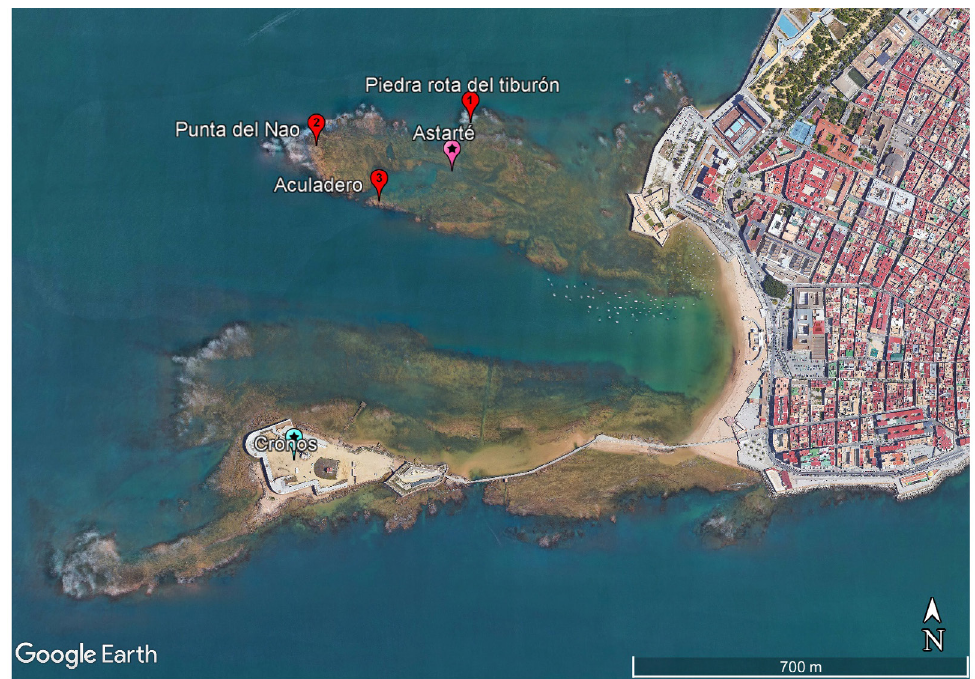
Figure 14. Experimental study of the Punta del Nao. Viewpoints on the present day map of Cadiz (Source: Google Earth. Own edition).